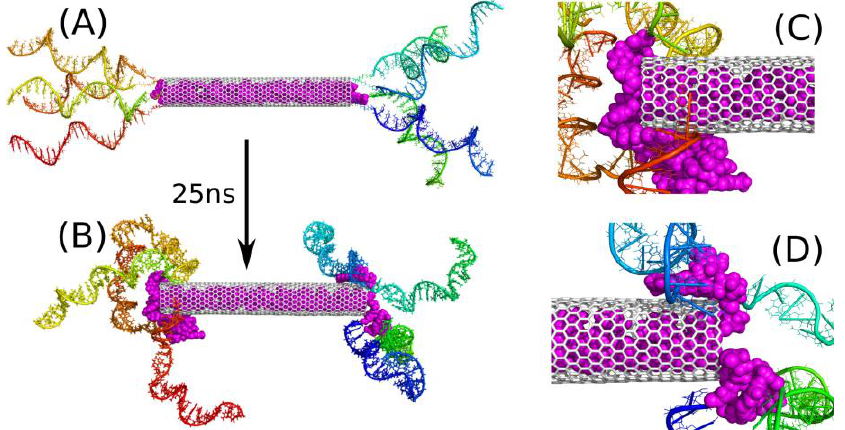
Figure 2. ( A ) Initial state of E4D20 system, i.e., with all DOX (magenta) molecules encapsulated in the CNT interior; ( B ) the state of E4D20 system after 25 ns of simulations. Zoomed-in sections of (B) showing the left ( C ) and right ( D ) end of the CNT with the released DOX molecules. The rainbow colors of iM chains are for illustration purposes only.